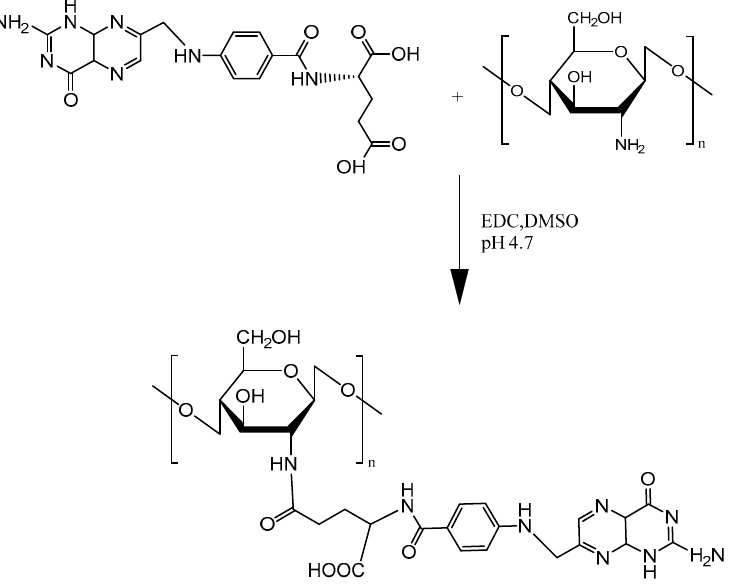
Figure 7. Schematic representation of folic acid-chitosan conjugation.